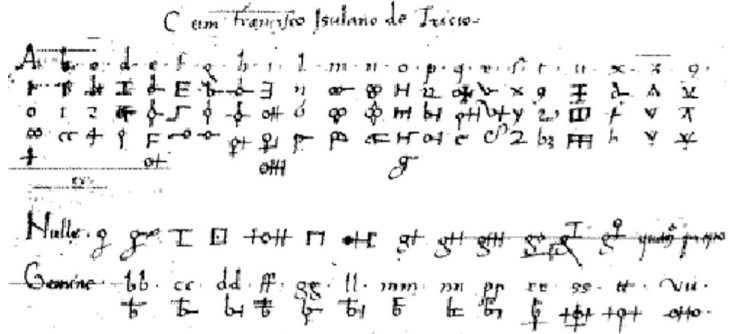
Fig 2. Homophonic alphabet example. Franciscus Tranchedinus , Codex Furtivae litterarum notae . Vindobonensis 2398, ca. 1450, showing the practice of using artificial, homophonic alphabet to conceal messages. Photo: Augusto Buonafalce (2008).